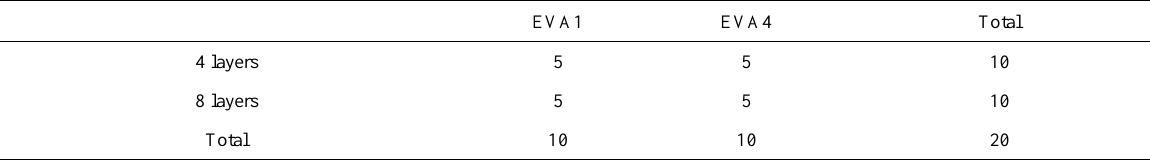
Table 8: Matrix for the desired samples of durability